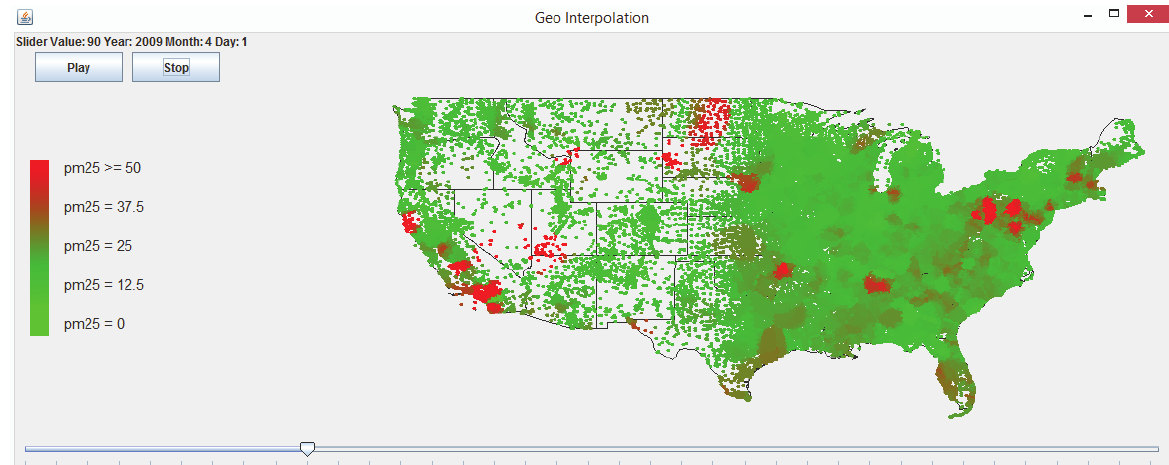
Figure 25. Interpolated PM visualization map for centroids of census block groups in the 2 : 5 contiguous U.S. on 1 April